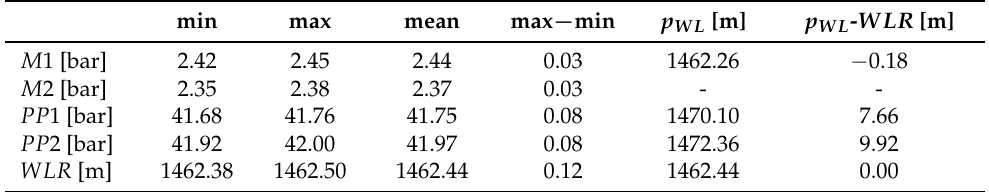
Table 1. Analysis of the zero measurement at the two added points M 1 and M 2, existing pressure measurements at both penstocks PP 1 and PP 2 and the water level ( WL ) in the upper reservoir ( WLR